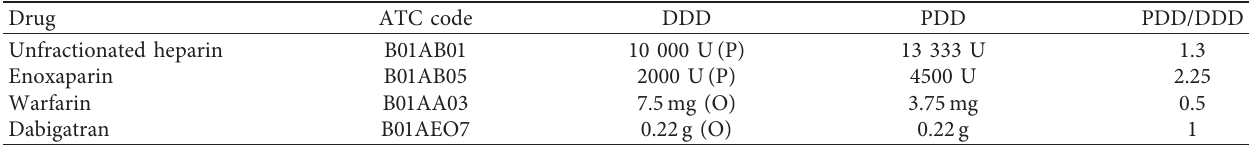
Table 4: Average prescribed daily dose (PDD/DDD) of anticoagulants.